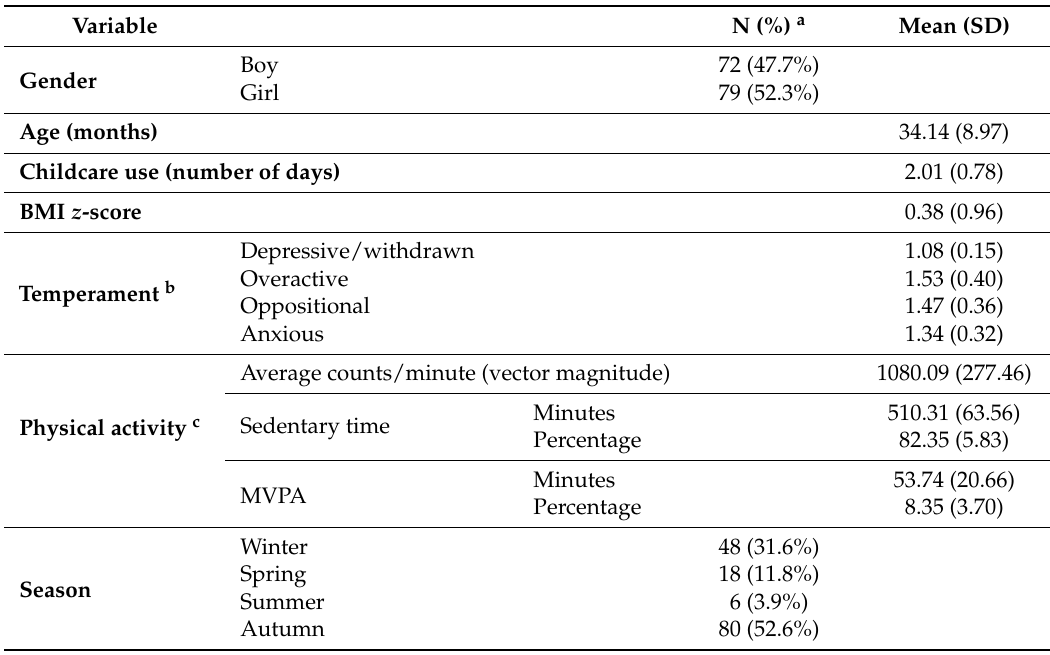
Table 1. Descriptive statistics of children’s characteristics and PA and measurement season ( N = 152).